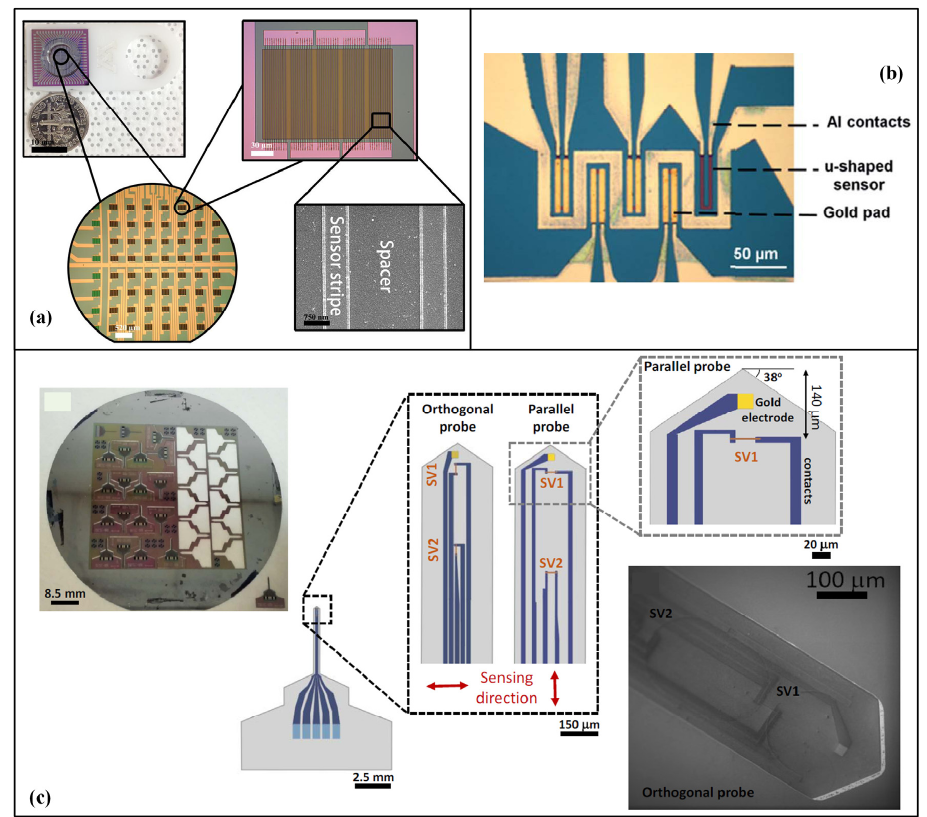
Figure 2. ( a ) Fabricated GMR chip for virus detection [39]; ( b ) GMR chips bonded on a printed circuit board for microfluidic platform (Adapted from [40] with permission of The Royal Society of Chemistry); ( c ) Integration of GMR sensors in needle shape micromachined silicon probes for neuronal magnetic field recording [28].